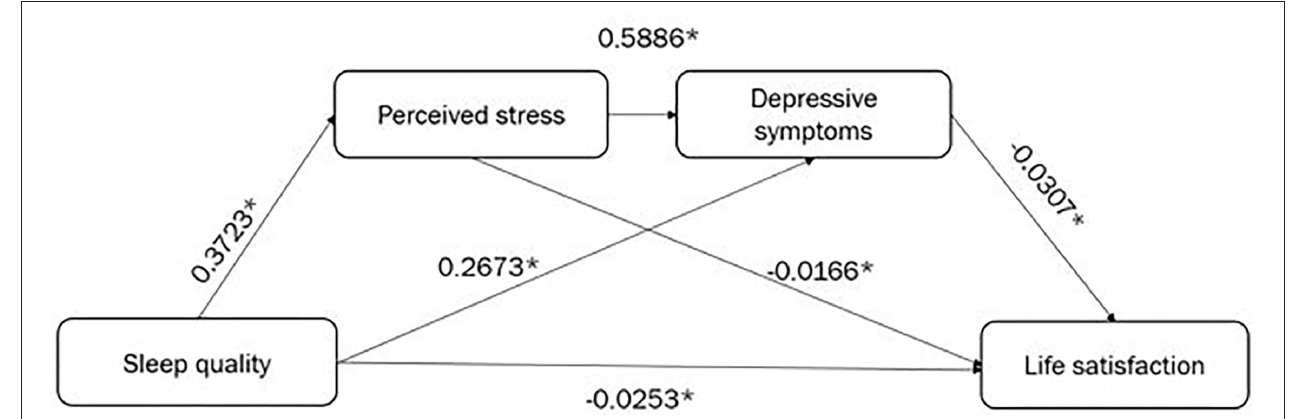
FIGURE 2 | The serial mediation of perceived stress and depressive symptoms. * P < 0.05, all results are statistically significant.